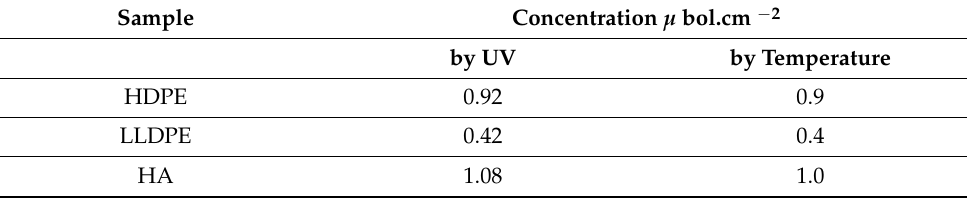
Figure 8. A comparison of the dynamic mechanical characteristics of pure HDPE and HDPE-HA Figure 8. AcomparisonofthedynamicmechanicalcharacteristicsofpureHDPEandHDPE-HAcomposites. composites . Table 4. Concentration of proposed work. Table 4. Concentration of proposed work.